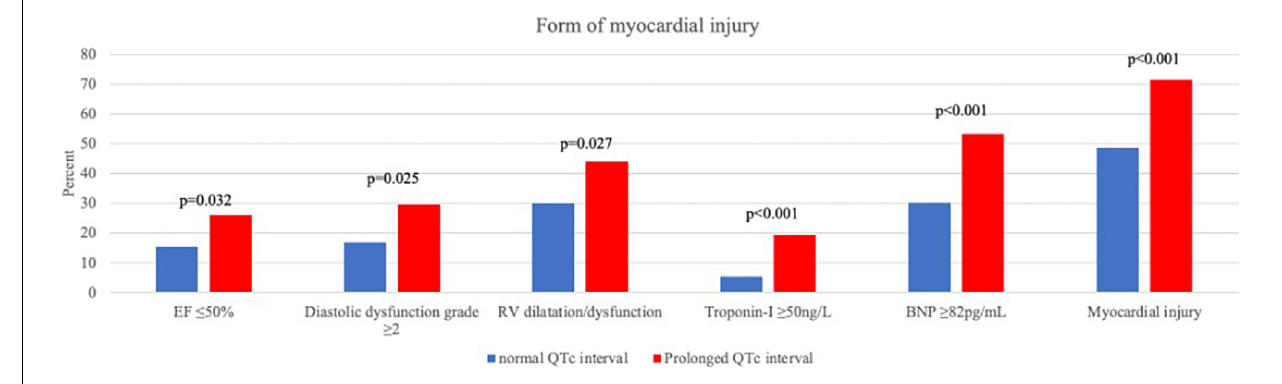
FIGURE 1 | Forms of myocardial